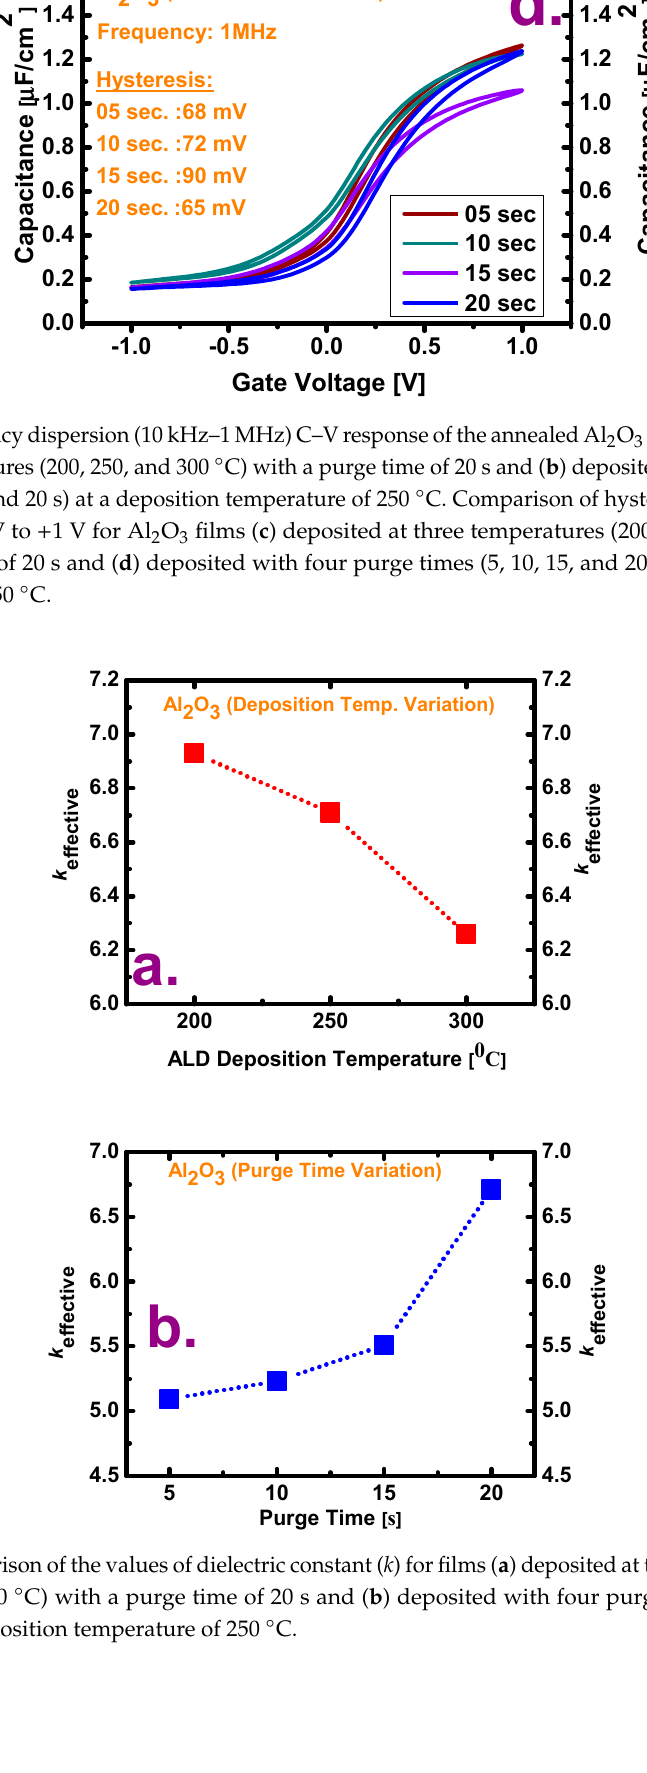
Figure 2. Comparison of the values of dielectric constant ( k ) for films ( a ) deposited at three temperatures (200, 250, and 300 °C) with a purge time of 20 s and ( b ) deposited with four purge times (5, 10, 15, and 20 s) at a deposition temperature of 250 °C.